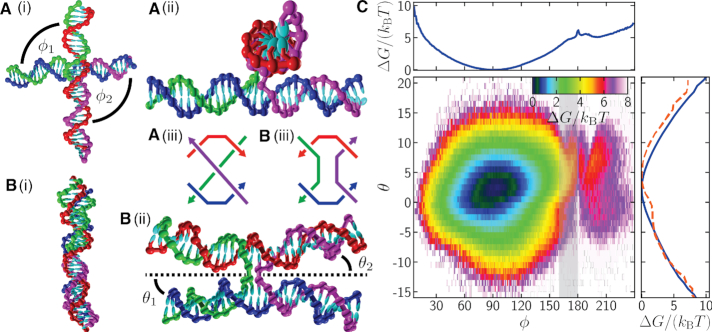
(A) and (B) OxDNA configurations for a single Holliday junction at 0.5 M salt that are representative of (A) the left-handed global free-energy minimum (ϕ = 95.5°, θ = 2.5°) and (B) an anti-parallel junction (ϕ = 180°, θ = 5°). (i) and (ii) provide perpendicular views of the configurations. In both cases the green and purple strands cross from one double helix to another, while the blue and red strands carry straight on along their double helix. (A)(iii) and (B)(iii) provide schematics of a left-handed parallel and an anti-parallel junction, respectively. (C) The Holliday-junction free-energy landscape as a function of ϕ and θ. One-dimensional free-energy profiles for ϕ and θ are also shown. The full free-energy profile for θ is shown as a solid blue line, while the dashed red line is for the subregion 160° ≤ ϕ ≤ 180°, shaded grey in the free-energy landscape. ϕ = (ϕ1 + ϕ2)/2 is a measure of the chiral twist of the junction, where ϕ1 and ϕ2 are the angles between the arms as indicated in (A)(i). θ = (θ1 + θ2)/2 is the average angle between each arm and the plane of the junction, as indicated in (B)(ii). The plane of the junction, represented by the dotted line in (B)(ii), is perpendicular to the plane of the paper and passes through the midpoints of the exchanging strands. The temperature used was 296.15 K.